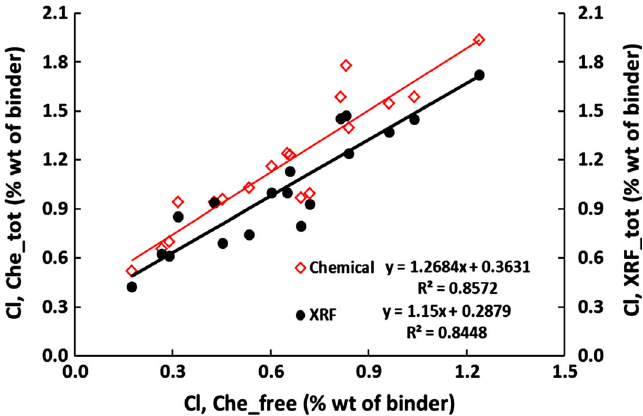
Fig. 14 Relationships between XRF and chemical analysis of total and free chloride content.